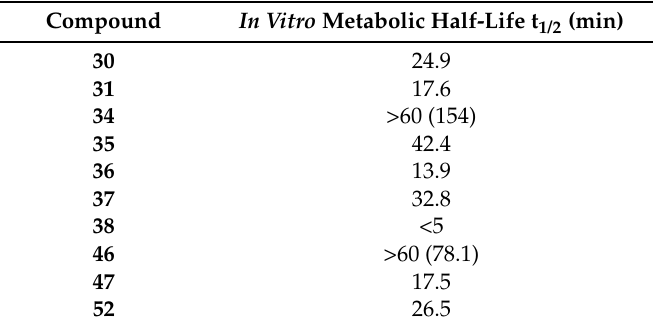
Table 3. Results of metabolic stability study.